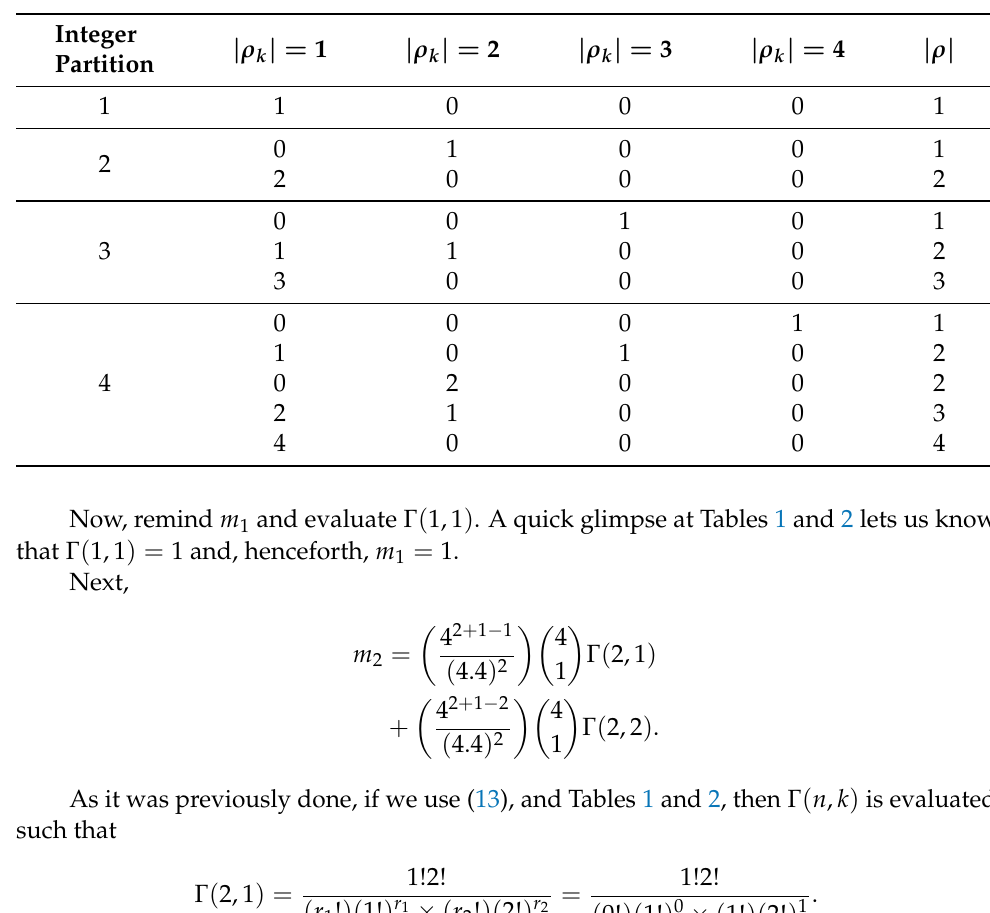
Table 2. Integer partition cardinalities of the subsets ρ k . It highlights the number of subsets with the same